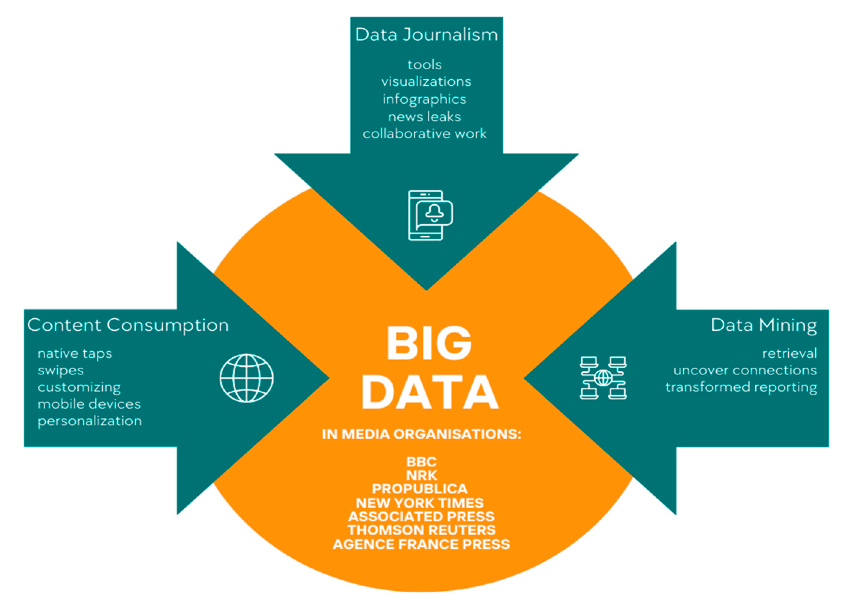
Figure 1. Application areas of big data in media organizations.